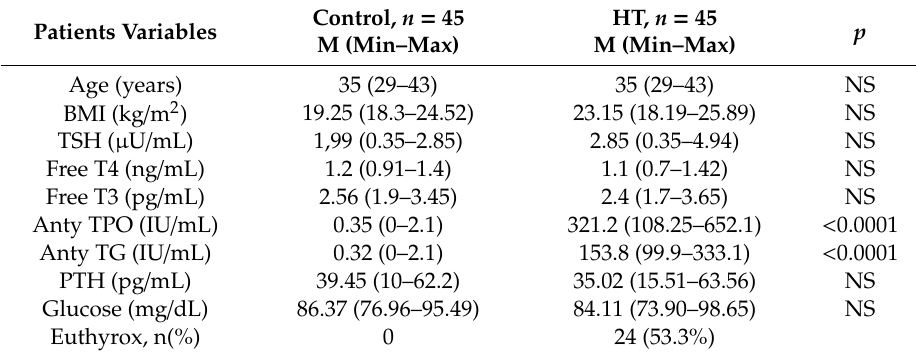
Table 1. Clinical characteristics of the patients and control